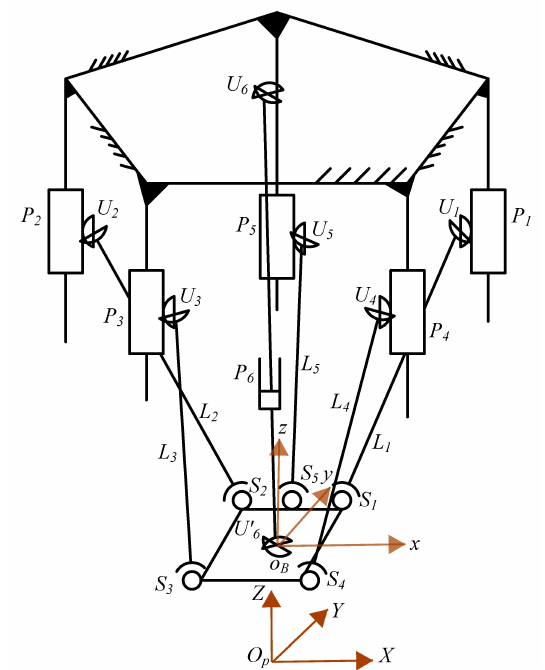
Figure 5. Mechanism schematic diagram of the improved